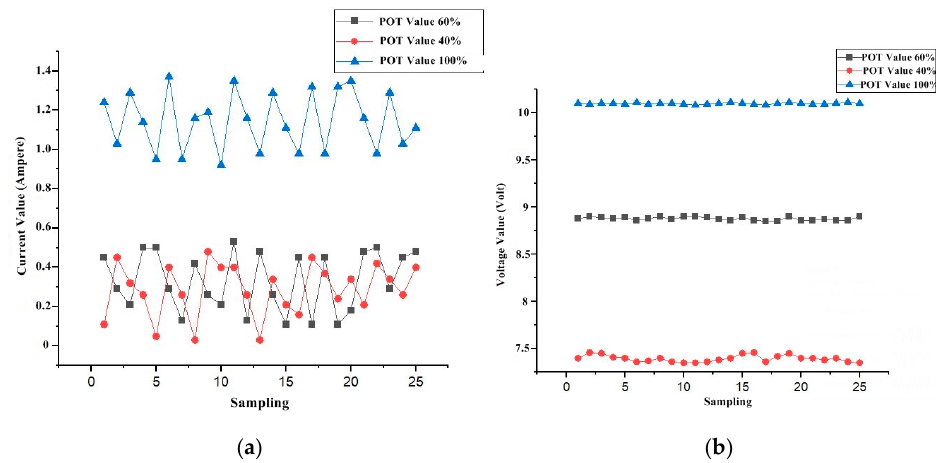
Figure 15. Precision Testing of hardware: ( a ) Current sensor precision testing; ( b ) Voltage sensor precision testing.